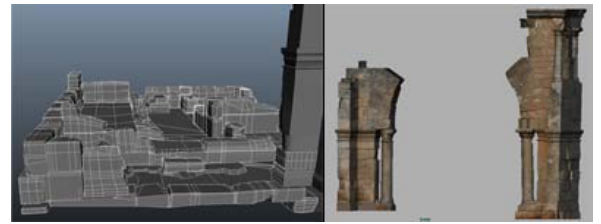
Figure 14. The 3D model of the arch and excavated area